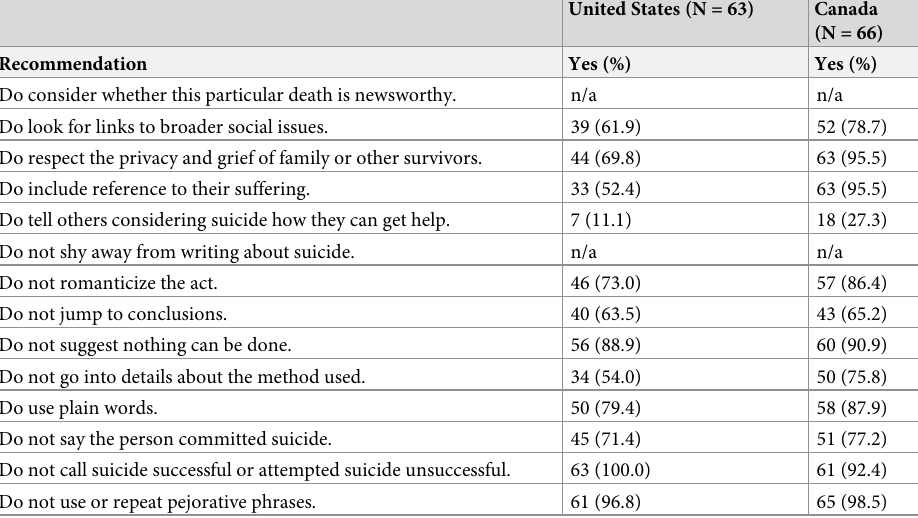
Table 2. Levels of adherence to Mindset guidelines in the U.S. and Canada in articles discussing Robin Williams’ suicide.